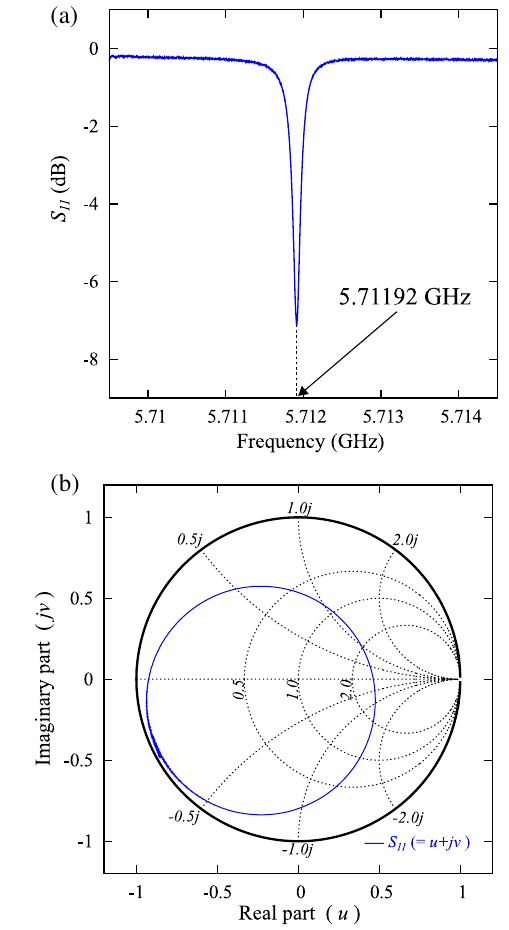
FIG. 12. (a) Frequency dependence of the measured j S 11 j . The horizontal axis indicates the frequency (GHz) and the vertical axis indicates the S 11 in decibel units (dB). (b) The measured S 11 in the format of the Smith